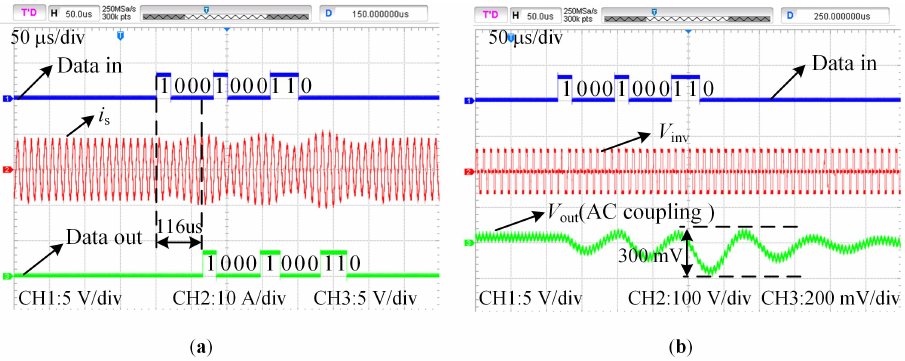
Figure 18. Measured waveforms of forward communication under the bit frame “10001000110”. ( a ) Transmitted data (Data in), secondary current i s and received data (Data out). ( b ) The ripple of output voltage V out under k = 0.15 and R L = 25 Ω .